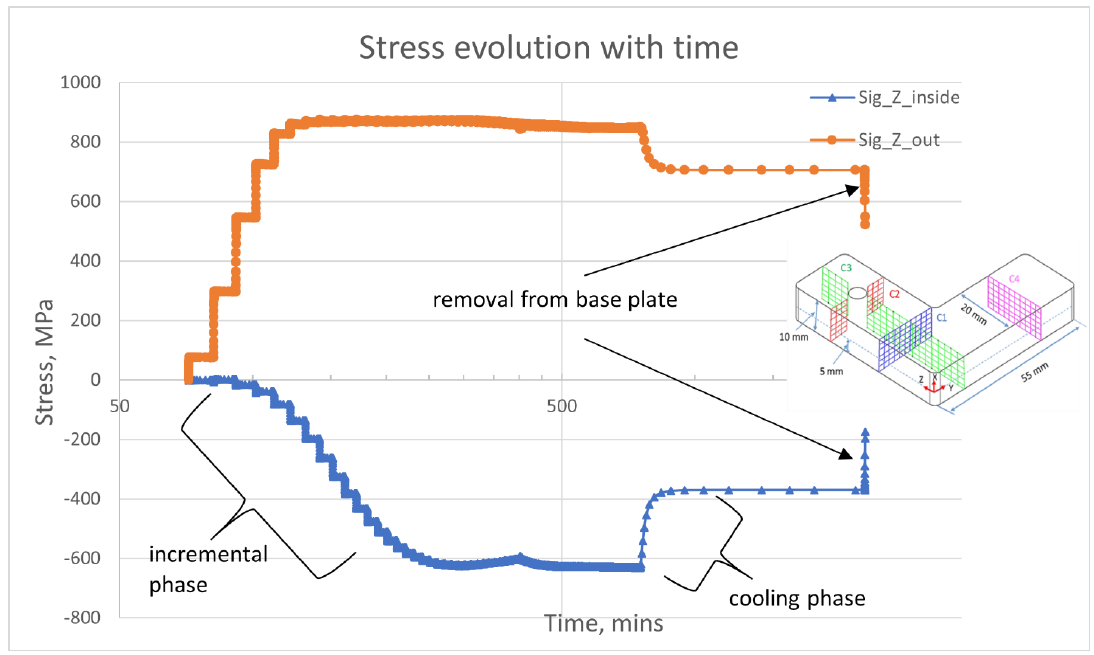
Figure 11. Stress evolution of elements in building direction for VB sample.